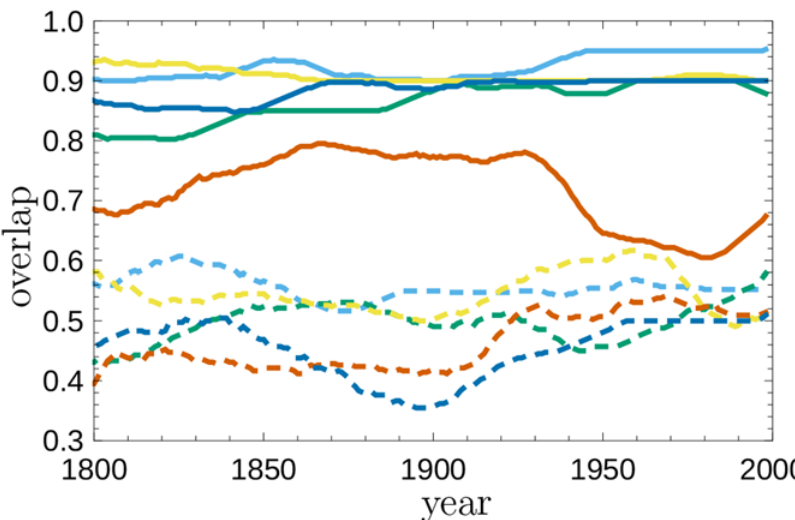
Fig 1. Overlap of the 20 most frequent words (continuous lines), and of the 20 most frequent content words (dashed lines) across languages, with respect to English, as a function of time. When words have more than one meaning, the first sense, according to Google Translate, was used. The color code for languages is as follows: light blue for French, green for German, yellow for Italian, dark blue for Spanish, and dark orange for Russian. Additionally, light orange will be used for English when required (see also Fig. 2). The same color coding for languages will be used throughout the rest of the article.